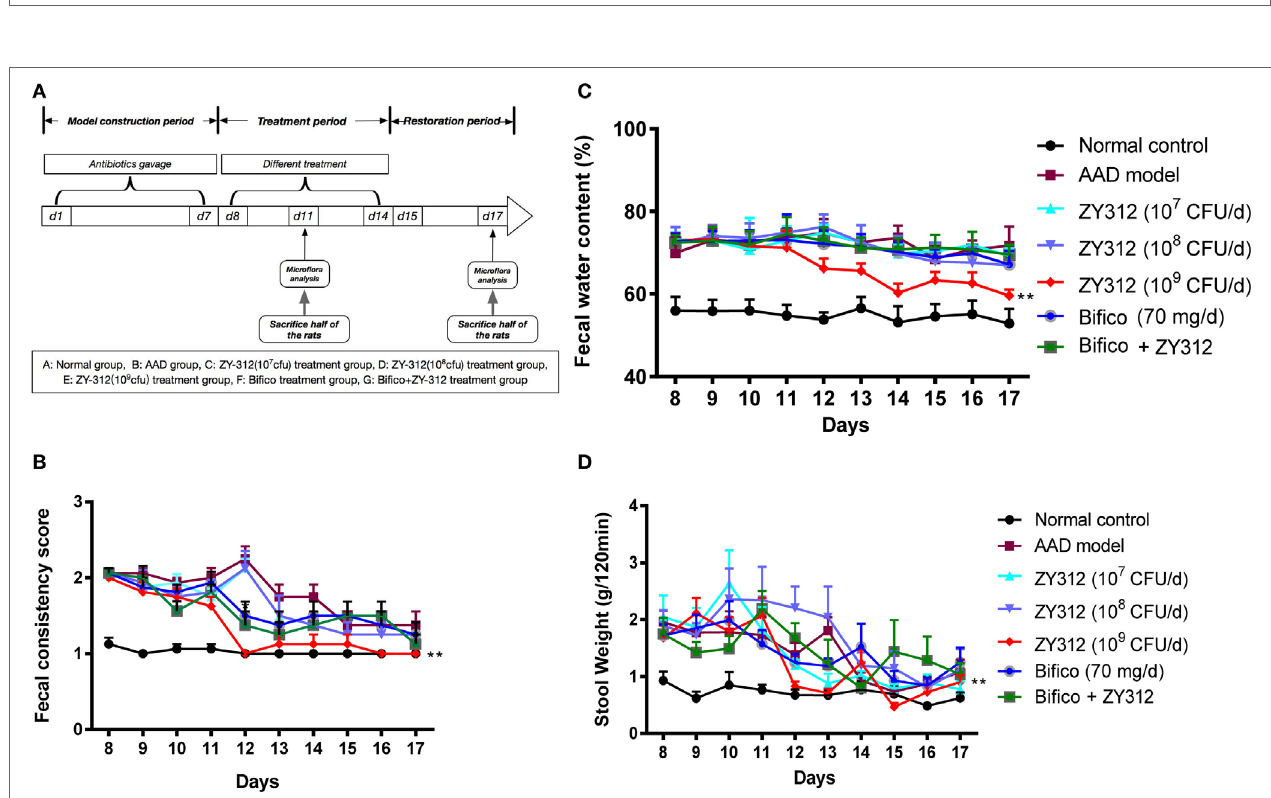
FigUre 2 | Disruption of SD rats microbiota by a mixture of antibiotics. (a,B) Bacterial culture for microbial community composition analysis of normal control rats and antibiotic-associated diarrhea rats induced by the medium dose of antibiotic cocktail. Abbreviations: BD, Bacteroides (in BBE agar); BL, Bifidobacterium (in TPY medium); LC, Lactobacillus (in Lactobacillus selective agar); EB, Enterobacteriaceae (in eosin-methylene blue medium); EC, Enterococcus (in CATC agar); SB, Saccharomycete (in DRBC agar); SP, Staphylococcus aureus (in Mannitol salt agar); CD, Clostridium (in reinforced Clostridium agar); PS, Peptococcus (in CDC anaerobic agar). t -Test, * P < 0.05 and ** P < 0.01 versus day